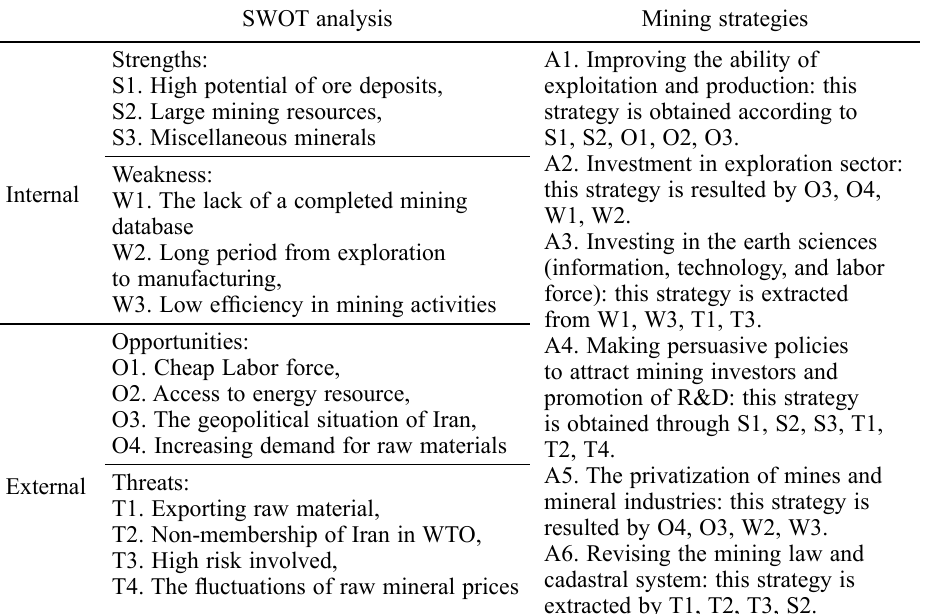
Table 2. SWOT analysis and strategic recommendations SWOT analysis Mining